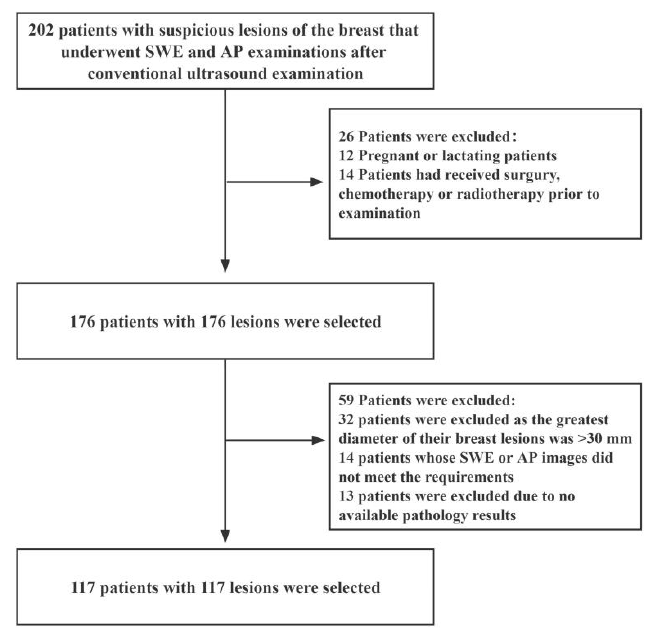
Figure 1. Flow diagram for the patient selection process. AP: Angio Planewave Ultrasensitive Imaging; SWE: Shear Wave Elastography.